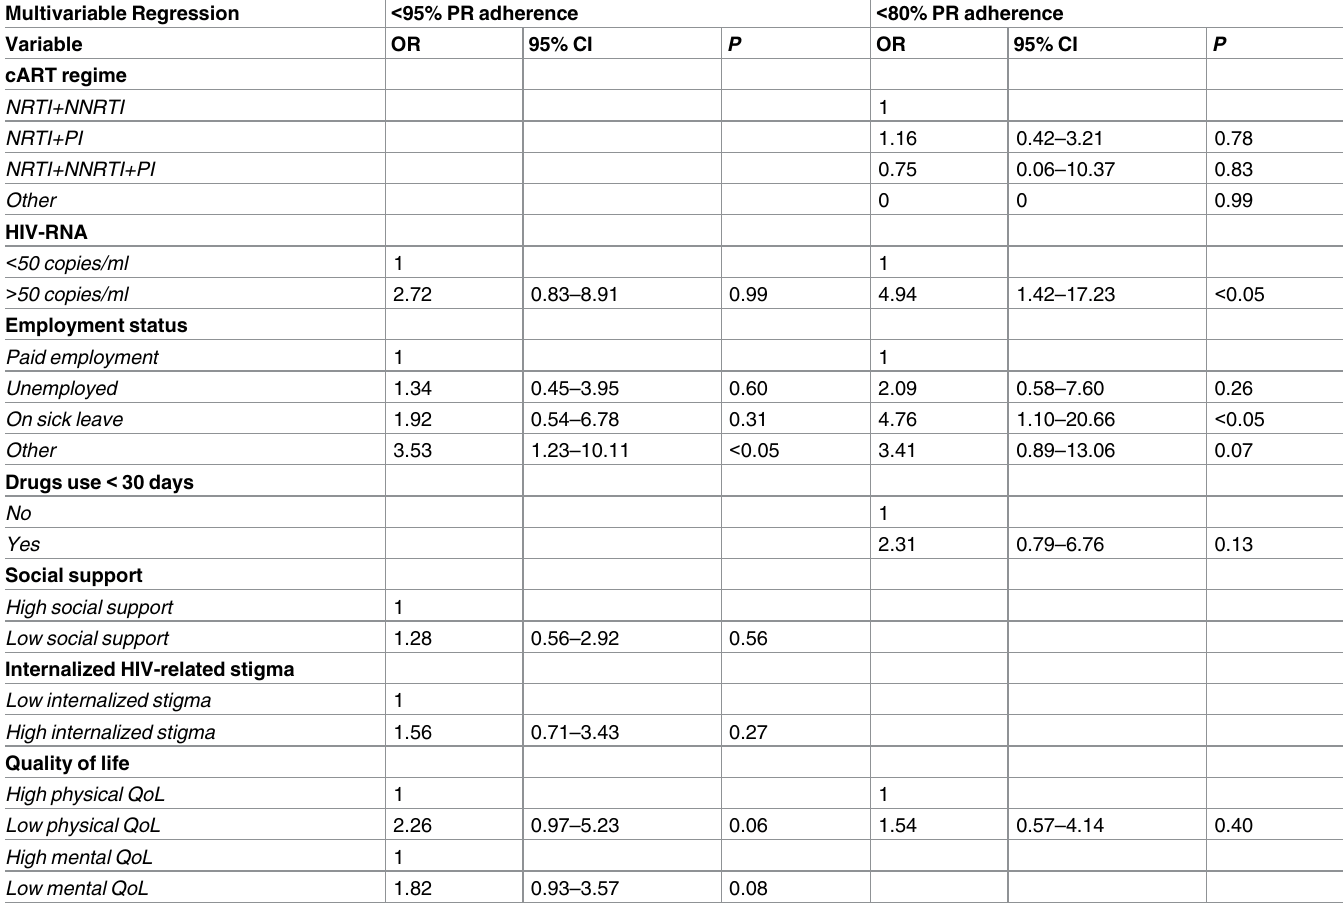
Table 3. Factors related to PRL